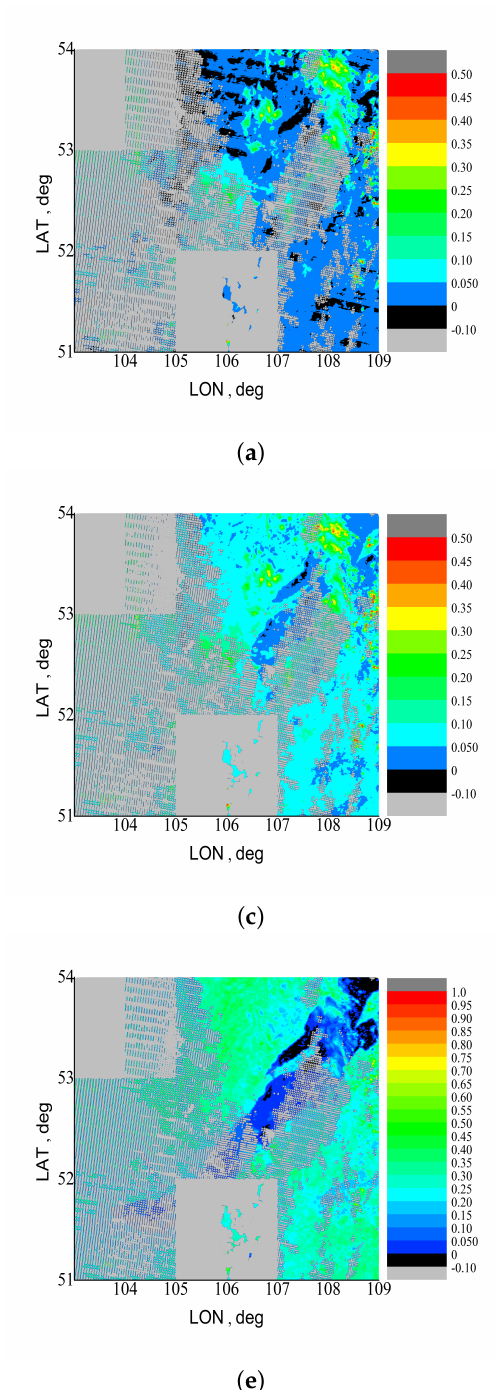
Figure 8. Ground surface reflectances for the considered region at 03:40 UTC of 7 July 2021, from MOD09 data after rejection of pixels with strong CAE: ( a ) MODIS band 8, ( b ) MODIS band 3, ( c ) MODIS band 4, ( d ) MODIS band 1, and ( e ) MODIS band 2. The values from 0 to − 0.1 correspond to the negative surface reflectance according to MOD09 data. The values smaller than − 0.1 correspond to areas covered by clouds or with strong